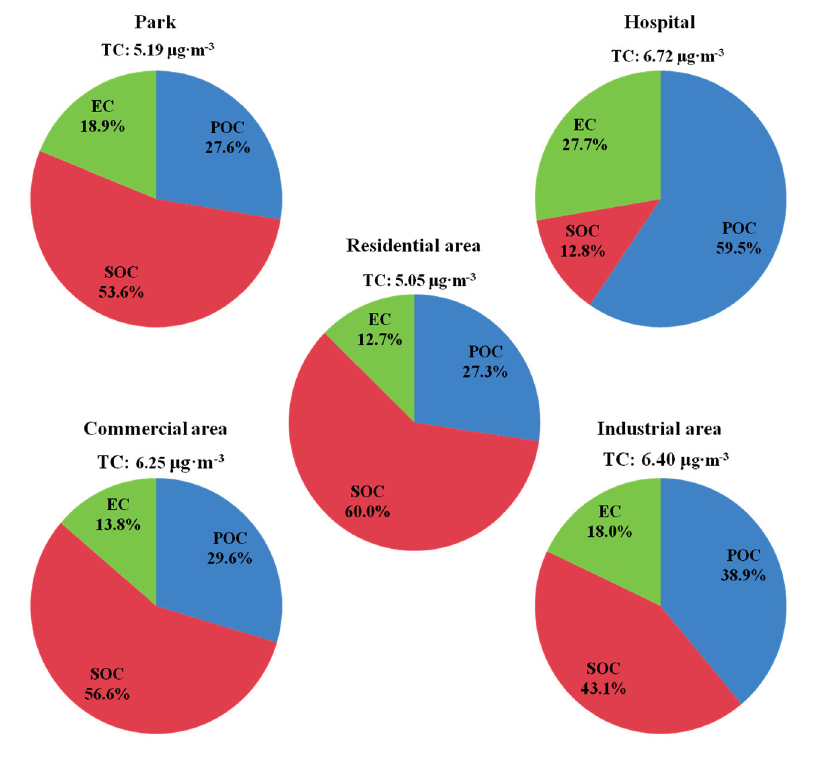
Figure 5. Relative contributions of primary and secondary sources to total carbon in the different functional areas in